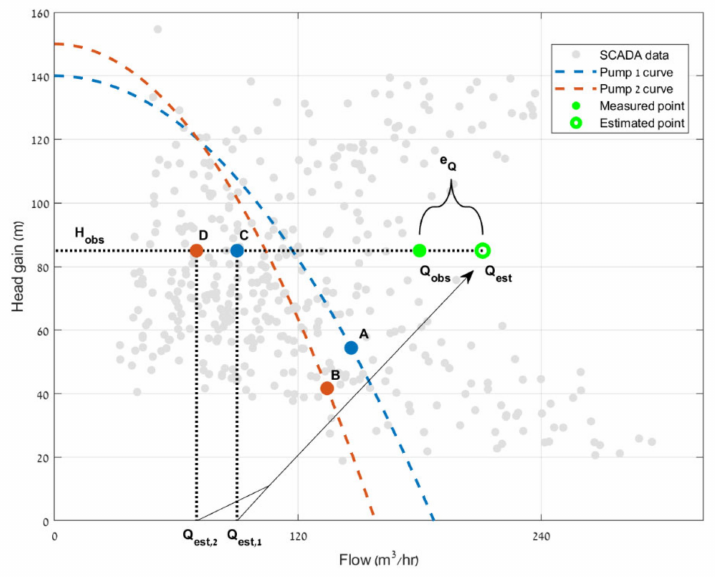
Figure 4. Calculation of the horizontal error for two variable speed